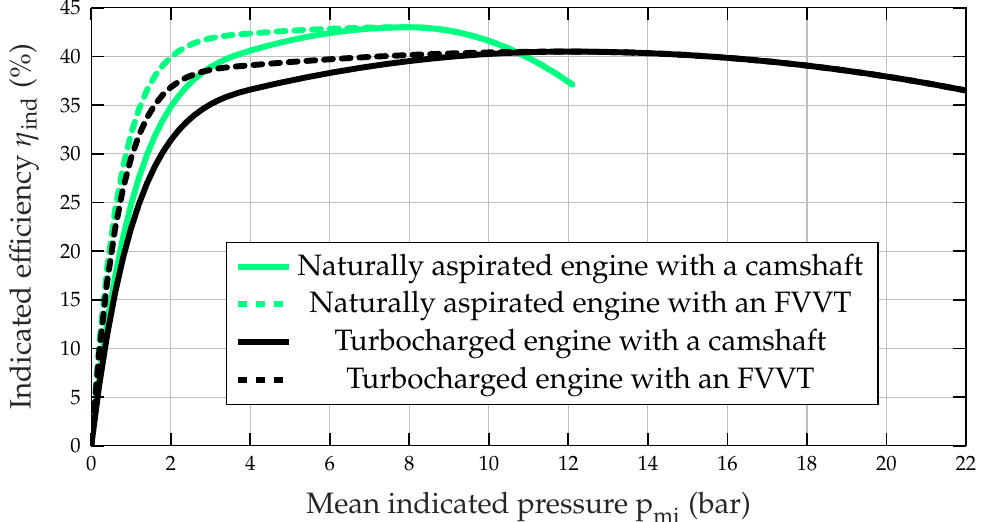
Figure 3. Plot allowing a comparison of the indicated efficiency of four different engine concepts. The lines colored show the indicated efficiency for a naturally aspirated engine, while the black lines show the indicated efficiency for a turbocharged engine. In the case of the solid lines, the engines are equipped with a camshaft, while in the case of the dashed lines, an FVVT is implemented instead.